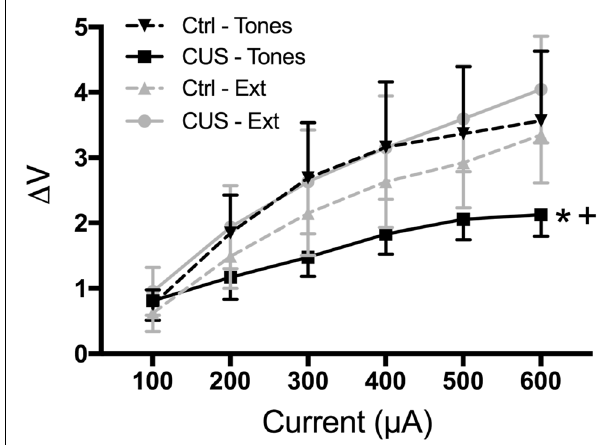
FIGURE 5 | Extinction therapy rescues chronic stress-induced attenuation of afferent-evoked electrical responses in IL medial prefrontal cortex. CUS compromised afferent-evoked field potentials recorded in the mPFC in response to stimulation of the medial dorsal thalamus ( ∗ p < 0.01, CUS/tone controls compared with unstressed/tone controls). Extinction treatment reversed the effect of stress, restoring evoked responses to unstressed control levels ( + p < 0.001, CUS/extinction compared with CUS/tone controls); n = 5–8 rats per group. Data expressed as mean ± SEM. Reproduced with permission from Fucich et al.